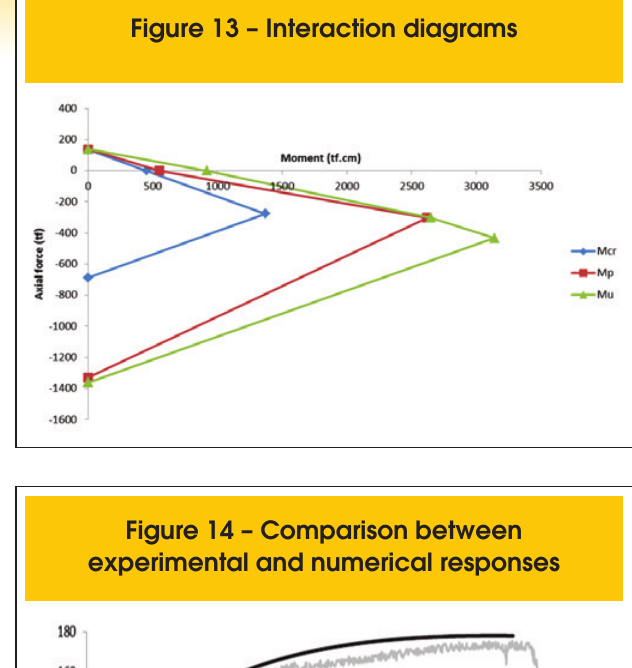
Figure 13 – Interaction diagrams